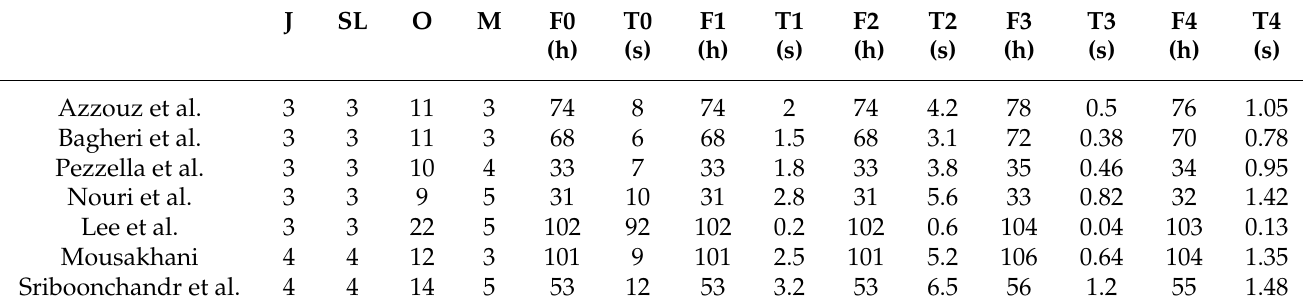
Table 9. Computational results of the developed resolution methods for instances adapted from the